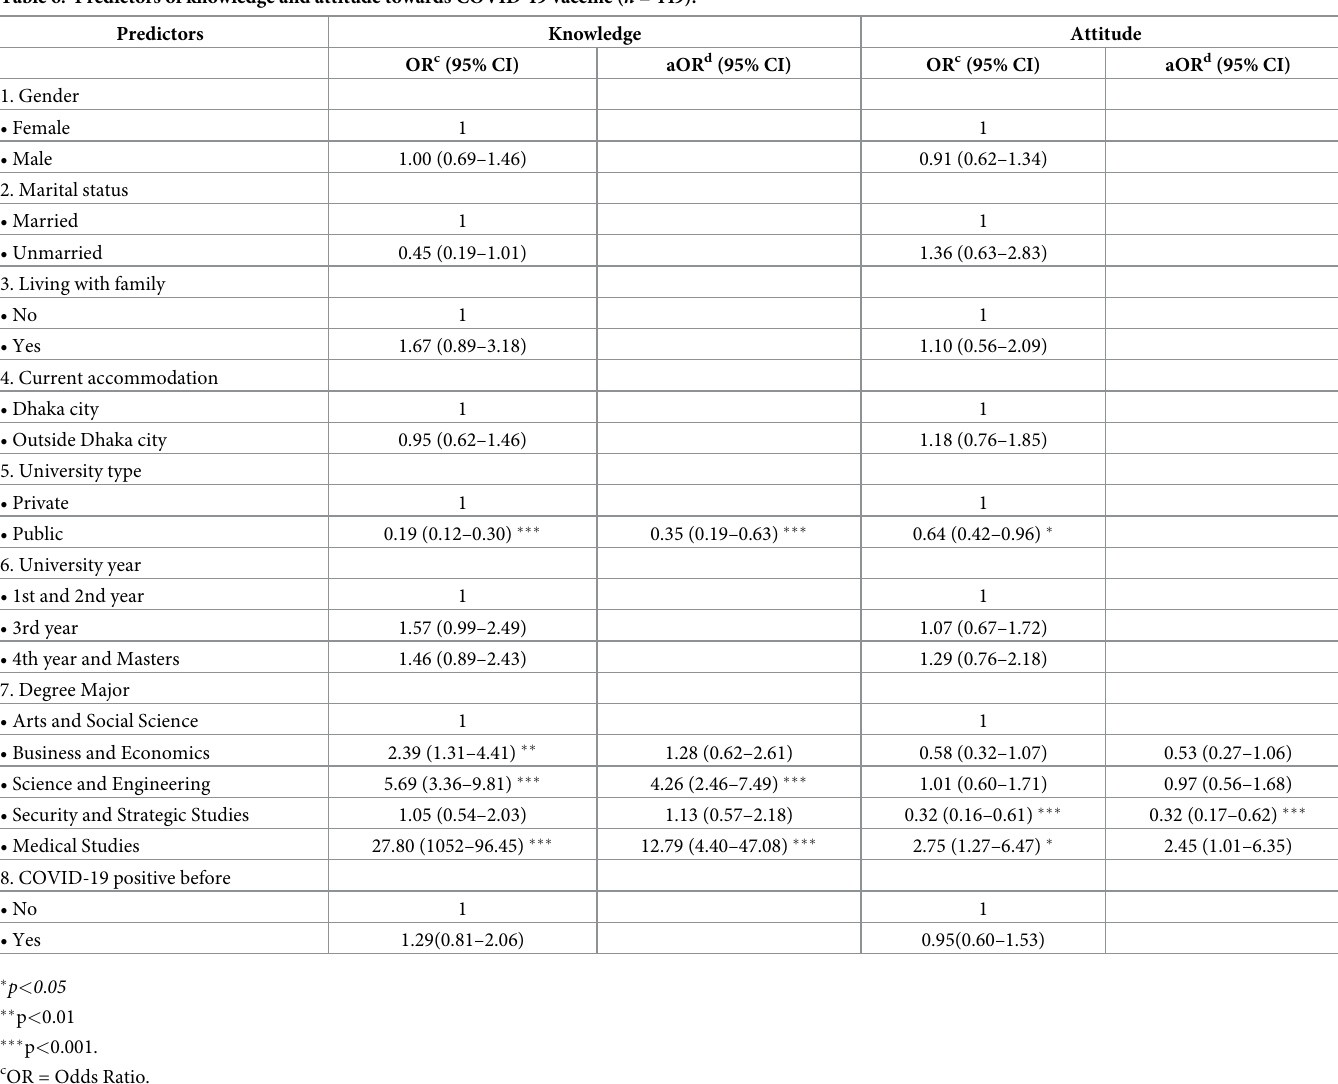
Table 6. Predictors of knowledge and attitude towards COVID-19 vaccine ( n = 449).